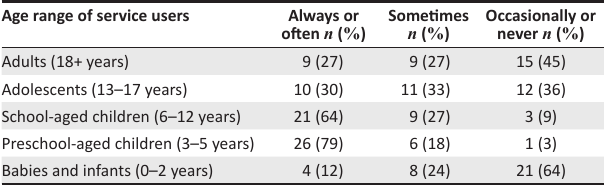
TABLE 2: Permanency (applicable roles), overall and by funding sector. Variables